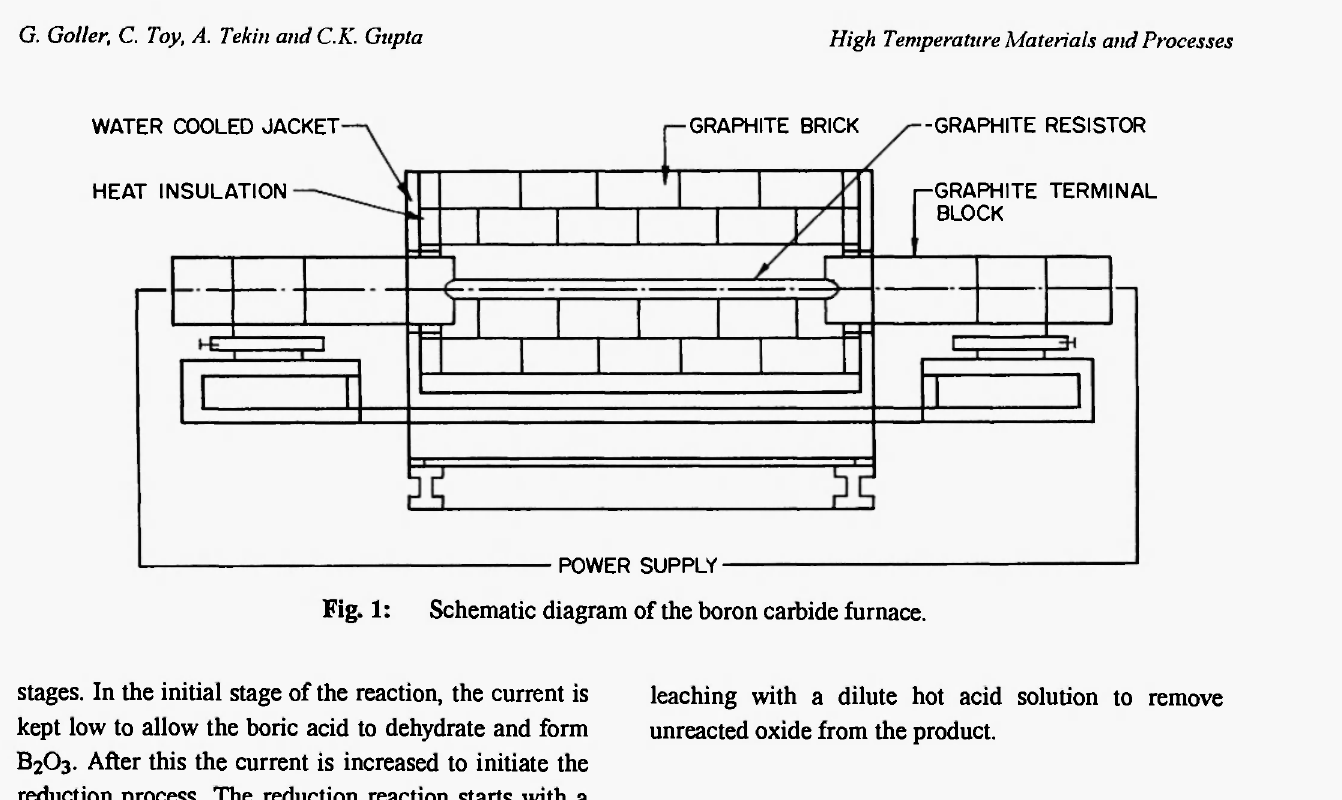
Fig. 1: Schematic diagram of the boron carbide